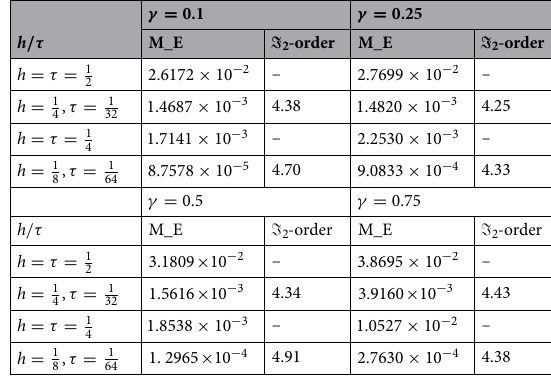
Table 7. Space variable convergence order for the Example 1.